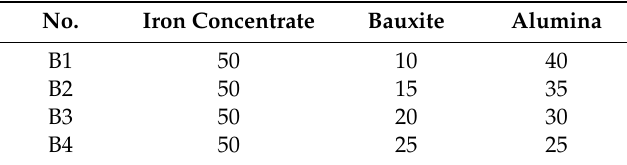
Table 2. The composition of composite formulation